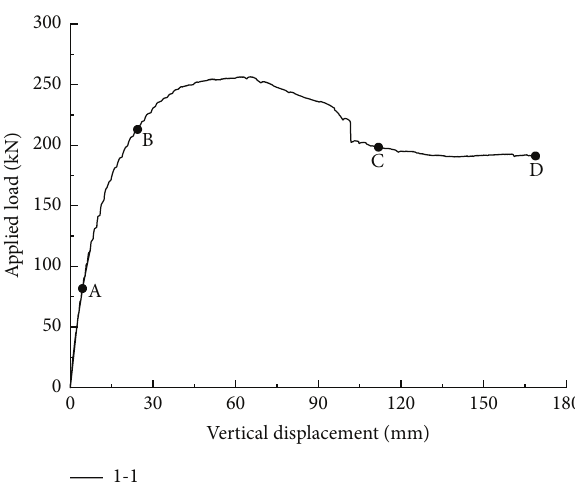
Figure 10: Applied load versus vertical displacement of the joint.